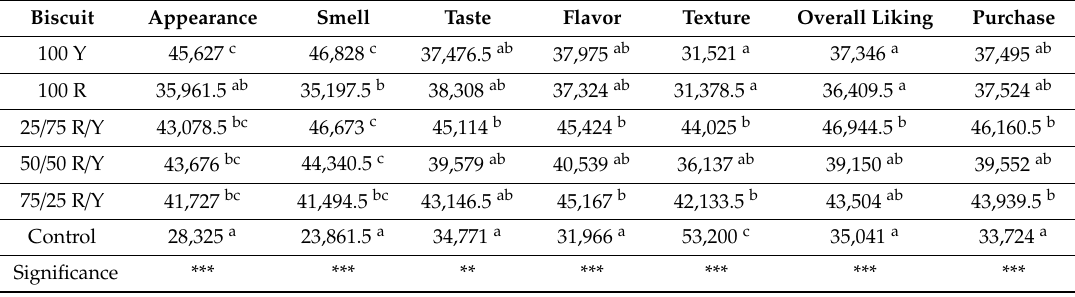
Table 7. Sum of the ranks for each sensory descriptor of the biscuits and results of Kruskall–Wallis test with mean comparison (R-red;